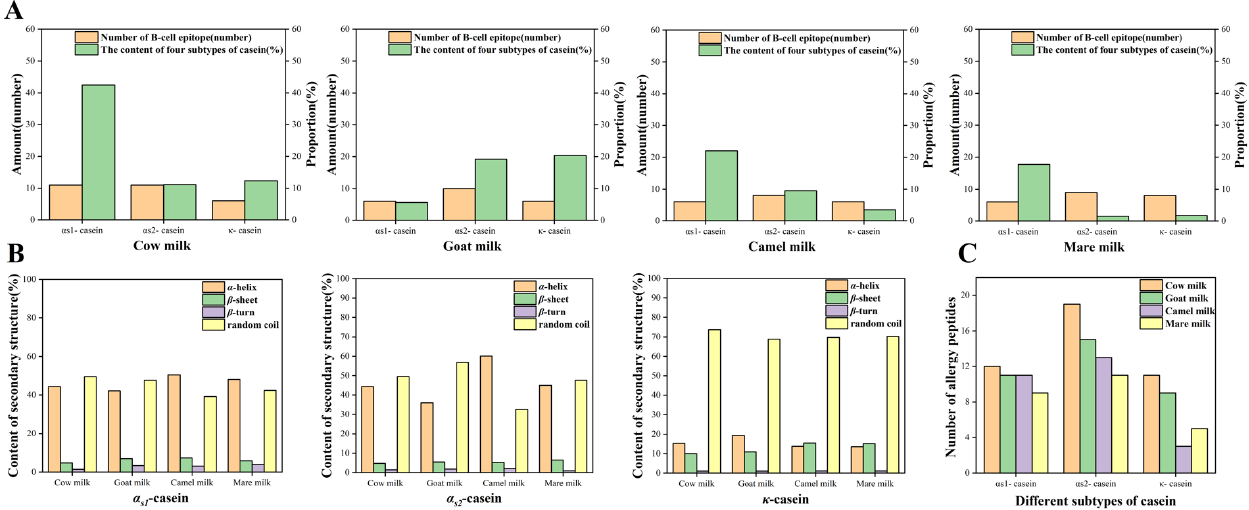
Figure 2. The predicted results of the linear B-cell epitopes ( A ); the secondary structures ( B ); and the allergenic peptides ( C ) of allergenic subtypes, respectively, in CM, GM, CAM, and MM. The panels in ( A ) represent the number of linear B-cell epitopes, as well as the corresponding allergenic subtype proteins that occupy the casein content (the left and right of the ordinate represent the amount of casein and the proportion, respectively). The panels in ( B ) represent the contents of the α - helix, β - sheet, β -turn, and the random coil of allergenic subtypes. Lastly, the panel in ( C ) represents the number of allergenic peptides.